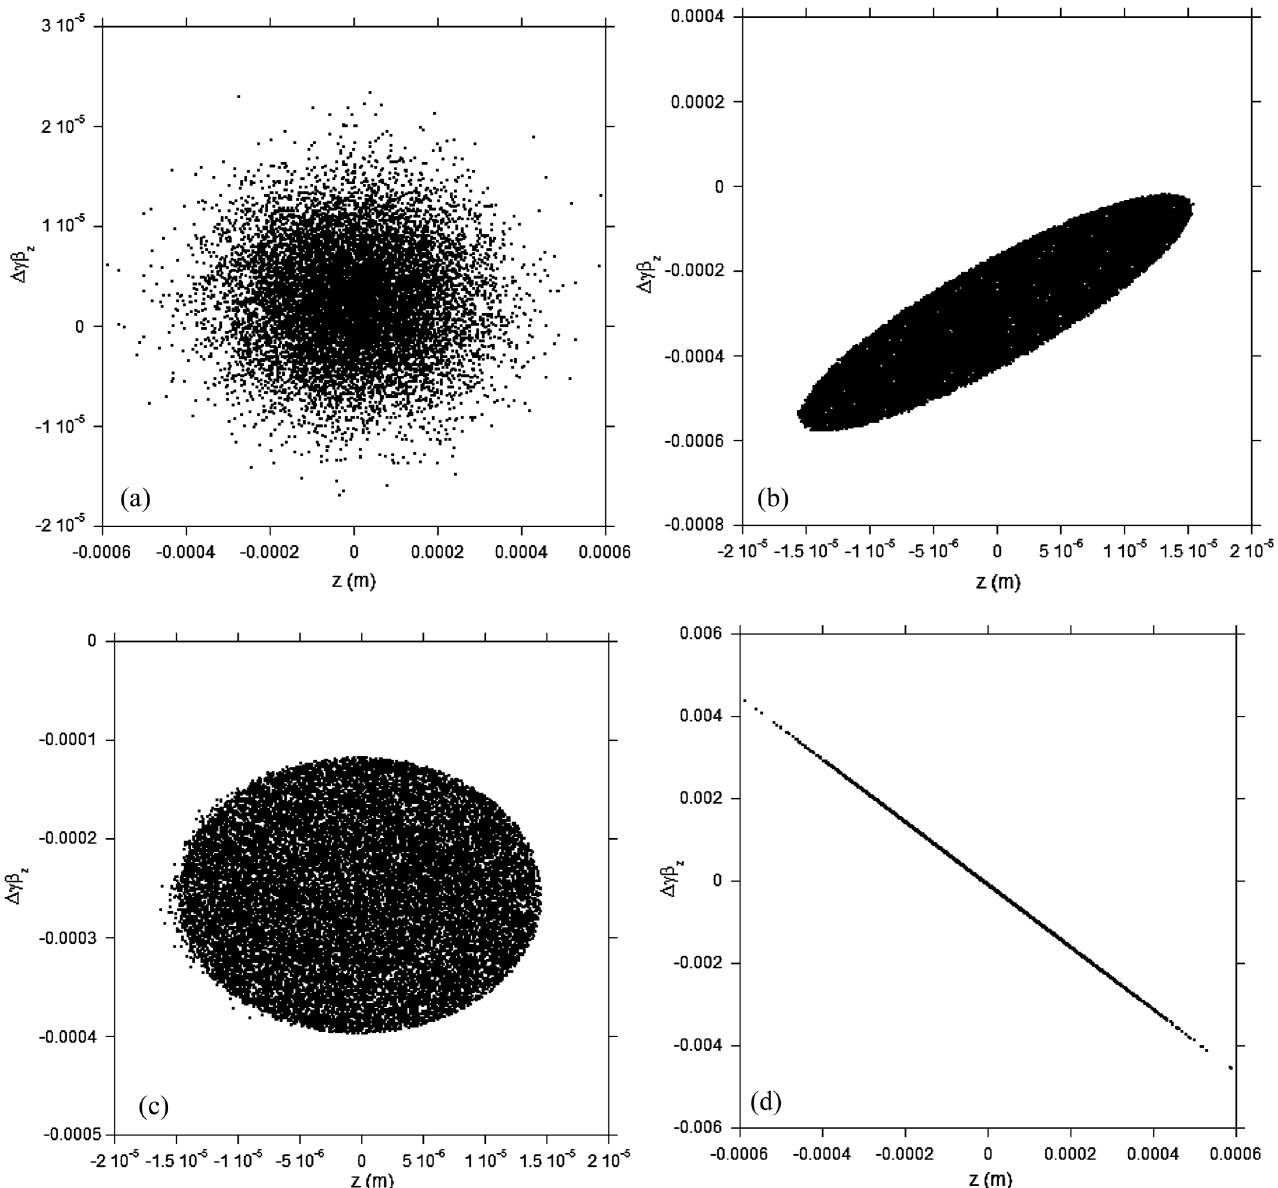
FIG. 6. Comparison of the initial longitudinal phase space (a) (the same for all three cases) and the final longitudinal phase spaces, for very low bunch charges, (b) case C, (c) case D, and (d) chicane. The different appearance of the initial phase space is because it was numerically populated with a Gaussian distribution in both position and energy deviation whereas the initial transverse phase spaces (and thus the final longitudinal phase space) were populated with a 4D K-V distribution. Case D clearly shows an uncorrelated final phase space, with a few stray particles at low axial positions demonstrating the transport